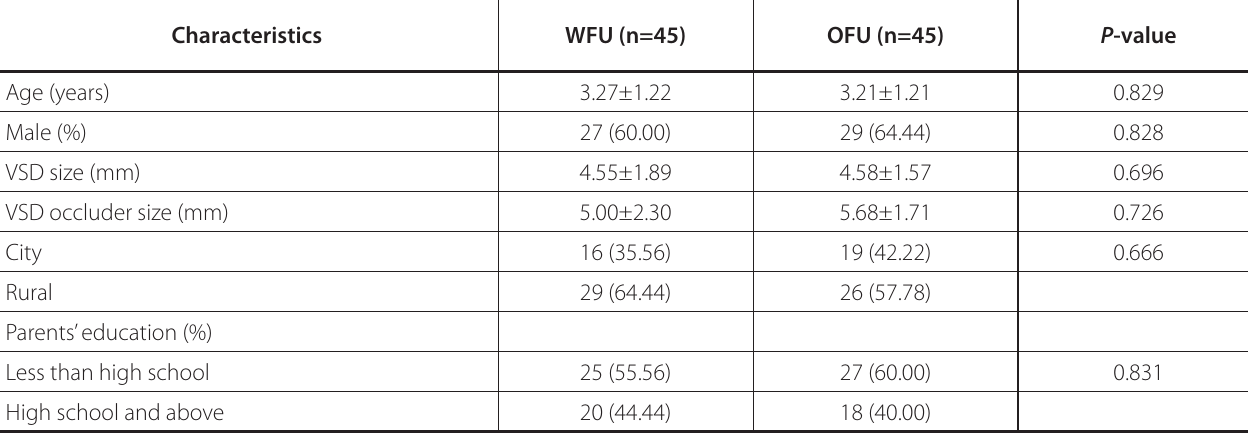
Table 1 . Selected baseline characteristics of the